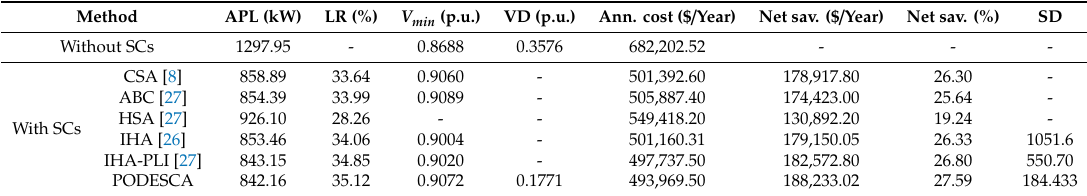
Table 12. Comparison of results between PODESCA and other methods for the 118-bus system.